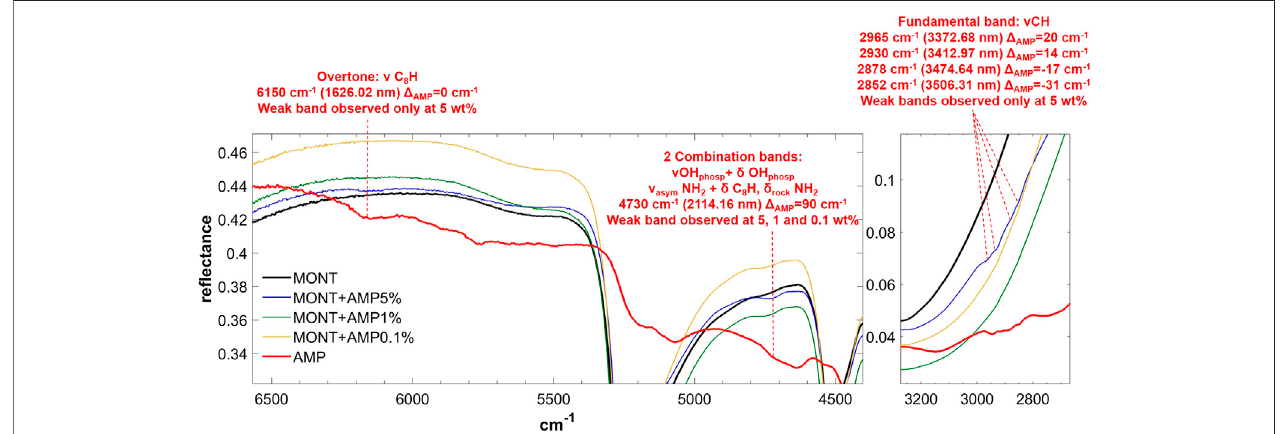
FIGURE3| NIRspectraofAMPadsorbedonmontmorilloniteat5,1,and0.1 wt%concentration.Legend: Δ AMP (cid:2) wavenumbershiftwithrespecttothesamepeak ofthepuremoleculeinthesolidstate;phosp (cid:2) phosphategroup; ν (cid:2) stretchingvibrationalmode; δ (cid:2) bendingvibrationalmode;rock (cid:2) rockingin-planevibrationalmode; asym (cid:2) asymmetric vibrational